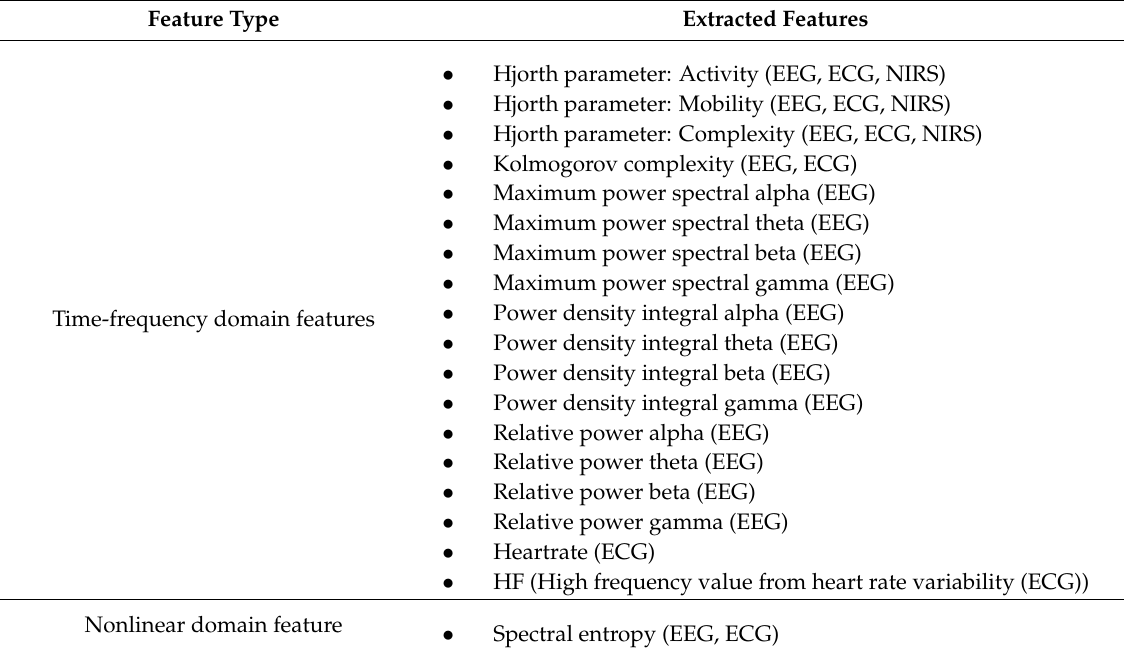
Table 2. Feature